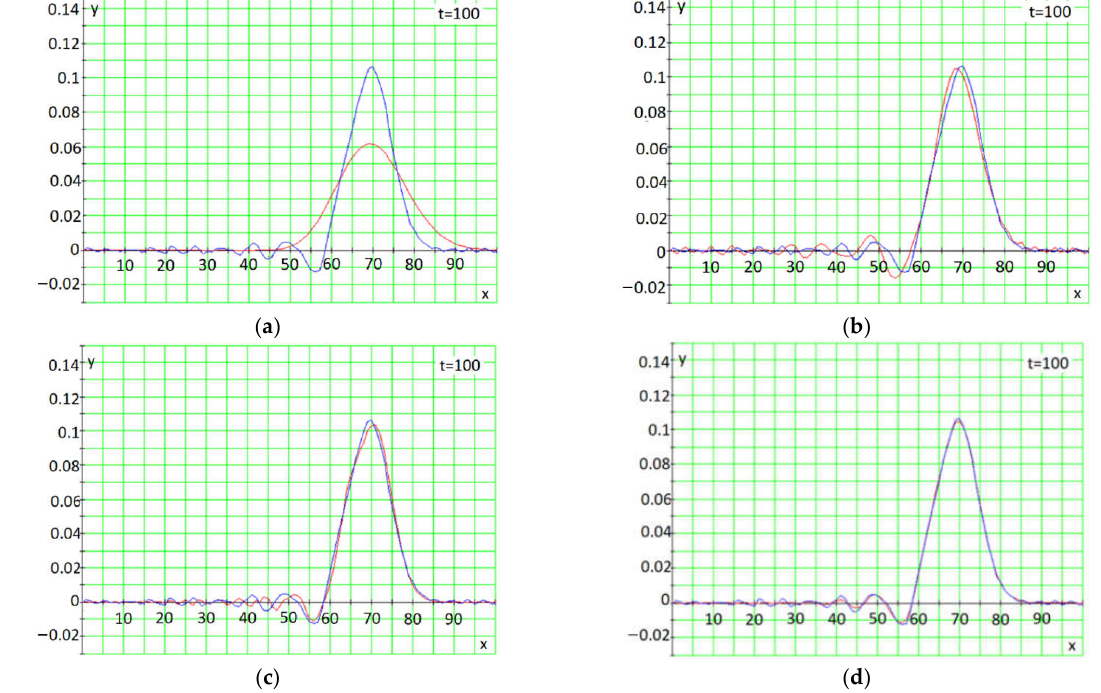
Figure 3. Comparison of accurate and numerical solutions of the linearized KdV test problem based on the schemes: “left corner” ( a ), the “Standard Leapfrog” ( b ), the “Upwind Leapfrog” ( c ), the scheme (7) ( d ); red line—numerical solution, blue line—analytical solution.